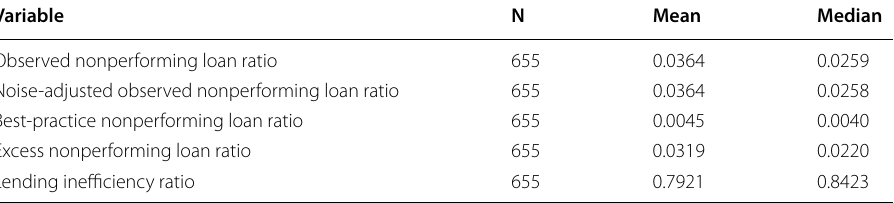
Table 5 2016 Unsecured consumer loans–stochastic frontier estimation. Excluding the volume of unsecured consumer lending. Best‑practice (minimum) ratio of nonperforming consumer loans